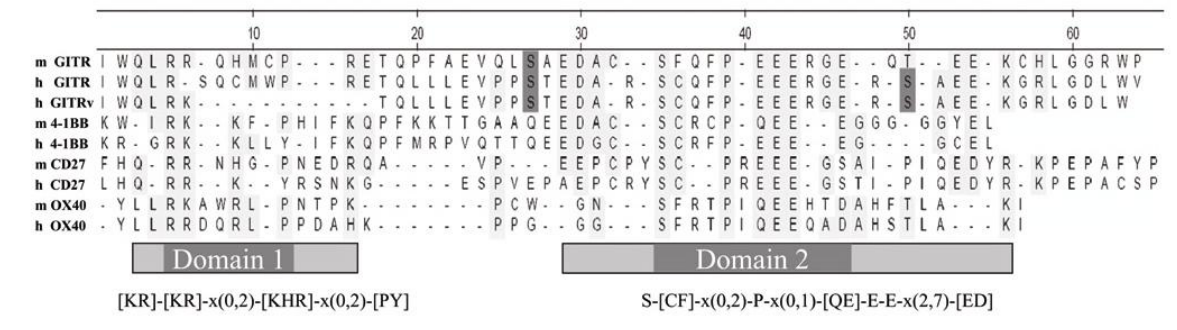
FIGURE 5. Homology among the cytoplasmic domain of GITR and the other human and mouse TNFRSF members of GITR subfamily. Comparison between all the cytoplasmic domains of mouse and human GITR (mGITR, from amino acid 177 to amino acid 228; hGITR, from amino acid 189 to amino acid 241; hGITRv, a splicing variant of hGITR, called variant 3, from amino acid 189 to amino acid 233), 4-1BB (m4-1BB, from amino acid 212 to amino acid 256; h4-1BB, from amino acid 214 to amino acid 255), CD27 (mCD27, from amino acid 202 to amino acid 250; hCD27, from amino acid 211 to amino acid 260) and OX40 (mOX40, from amino acid 234 to amino acid 272; hOX40, from amino acid 238 to amino acid 277). Amino acid residues identical or with similar function (I, V, M, L; H, R, K; E, D, N, Q; S, T; A, G; Y, F) present in more than 50% of the sequences are shaded. The serine in dark gray background are potential Casein Kinase II phosphorylation (CKII)